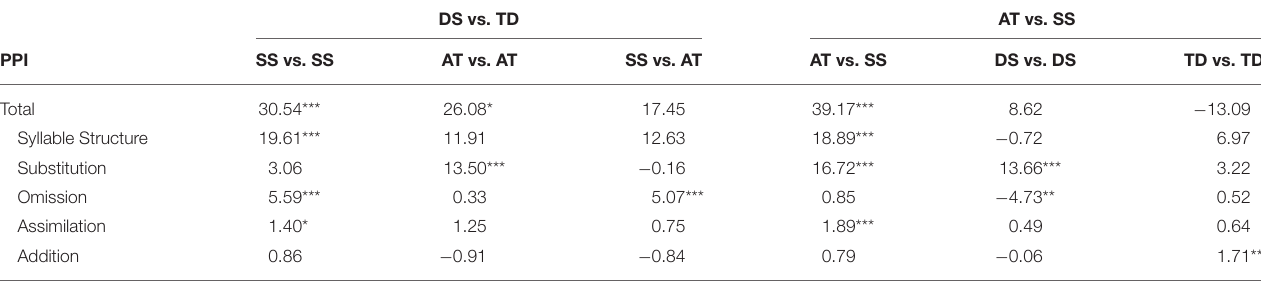
TABLE 2 | Subgroup differences in frequency of processes (PPI) and HSD Tukey post-hoc contrasts. DS vs. TD AT vs. SS